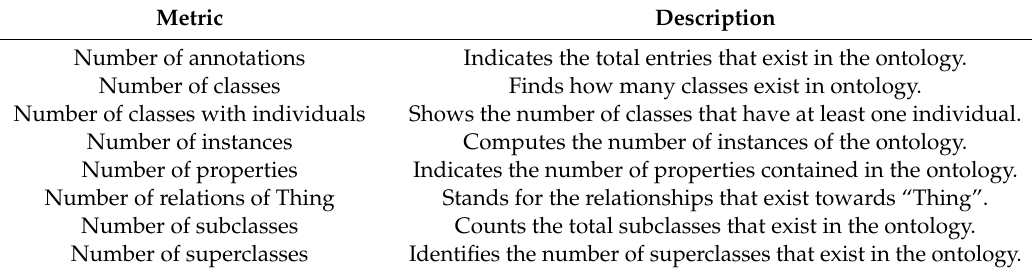
Table 2. Basic metrics implemented in OntologyFixer.